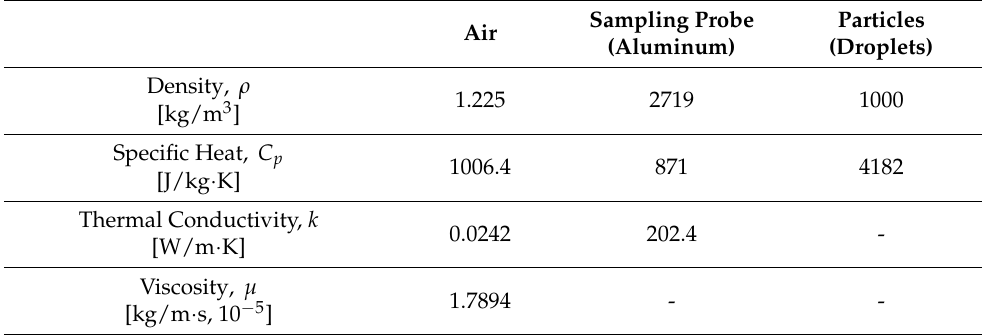
Table 1. Physical properties of fluid and solid